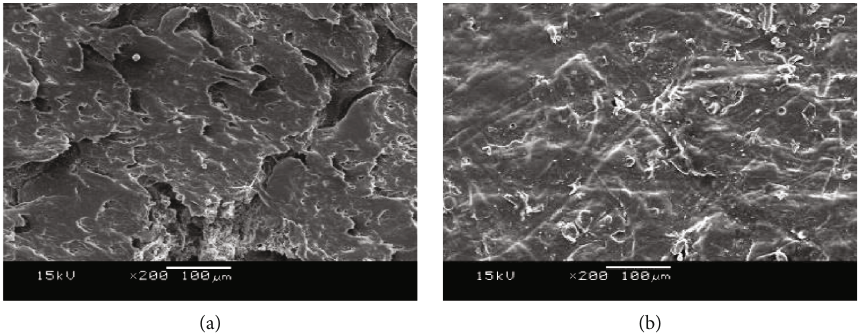
Figure 5: The SEM of 60/0 (a) and 50/10 (b) samples after immersing in n-hexane.